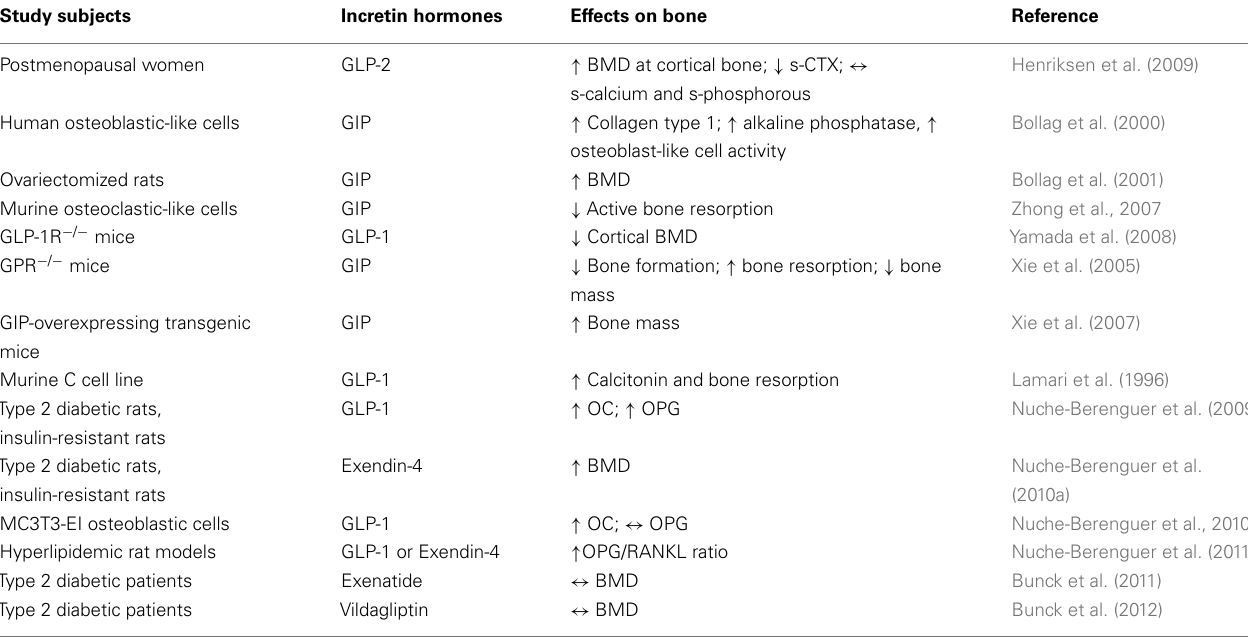
Table 1 | Effects of incretin hormones on bone